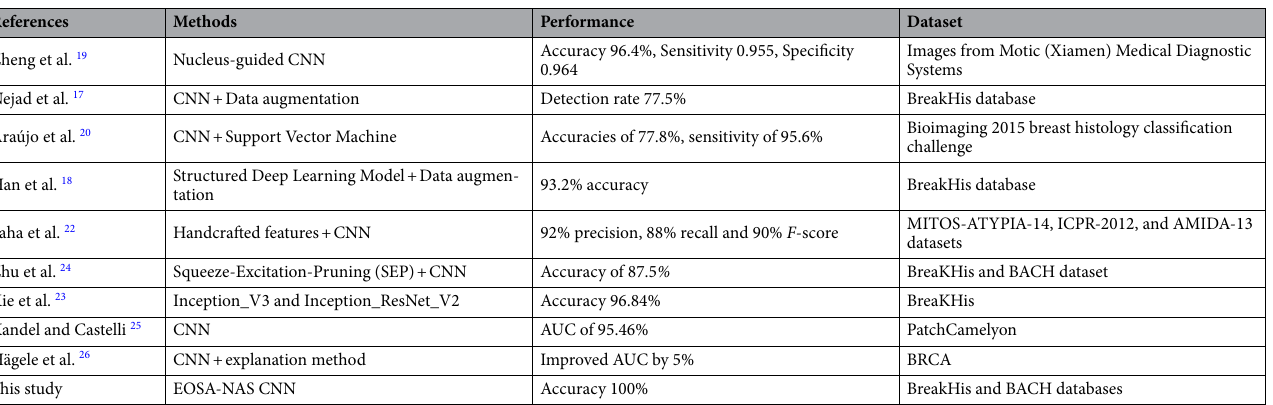
Table 12. Comparison of NAS-based CNN design with state-of-the-art canonical CNN design approach for detection and classification of breast cancer using histopathology images.